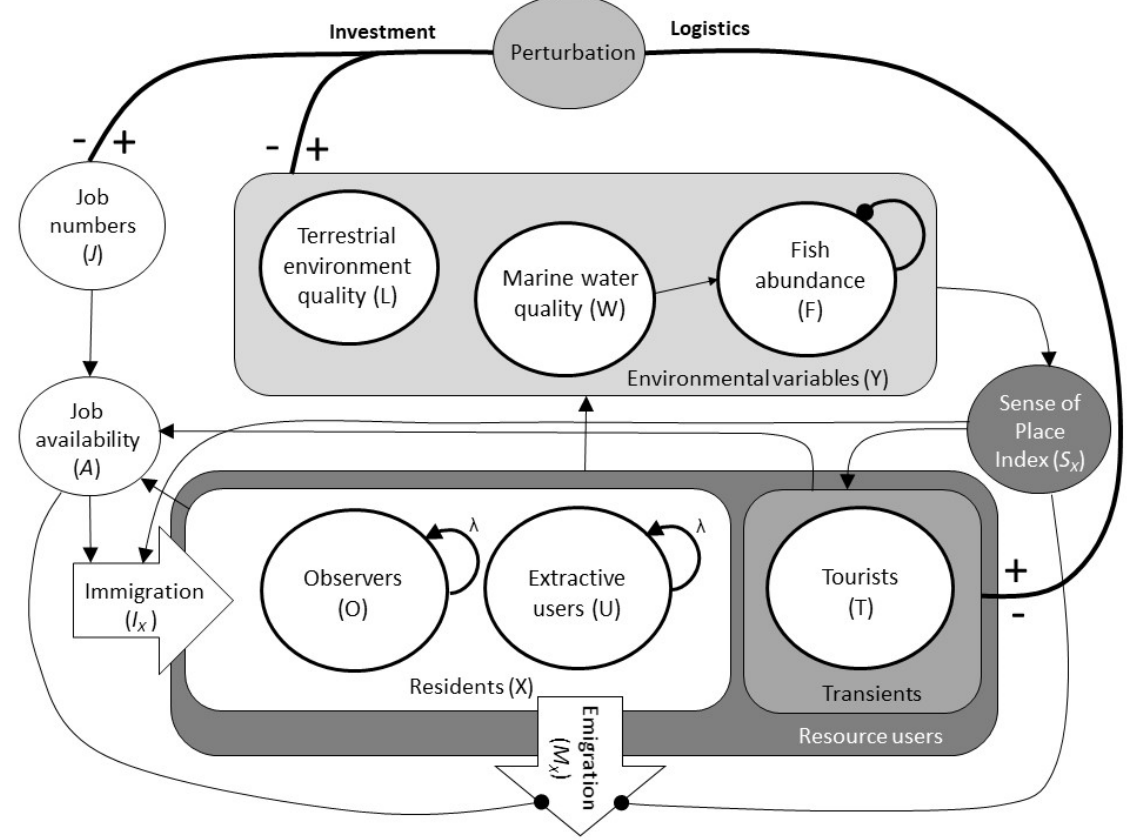
Figure A1.1: Conceptual model of a simplified socio-ecological system. Positive relationships are indicated by line ending with an arrow, and negative influences are indicated by line ending with a dot. The relationship between job numbers and job availability, which positively influence immigration and negatively influence emigration of residents is indicated with solid lines. The relationship between the quality of the environmental variables, the sense of place index (SoPI), is also indicated. A reactive response to more pristine or better quality environmental variables may lead to higher levels of the SoPI, which positively influences immigration of residents and transient numbers and negatively influences emigration. The interactions between the environmental variables are shown by the arrows in the environmental variables box. The relationship between job availability and residents are also